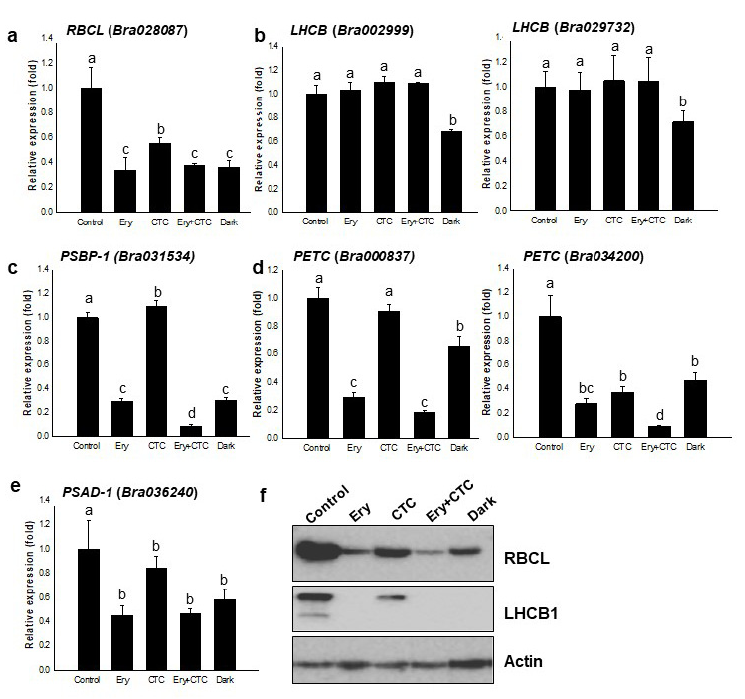
Figure 4. Effect of veterinary antibiotics on expression of genes and proteins involved in photo- synthesis. ( a ) Expression of RBCL (ribulose bisphosphate carboxylase large subunit; Bra028087 ). ( b ) Expression of LHCB (light-harvesting complex Chl a/b-binding protein; Bra002999 and Bra029732) . ( c ) Expression of PSBP-1 (photosynthetic II subunit P-1; Bra031534 ). ( d ) Expression of